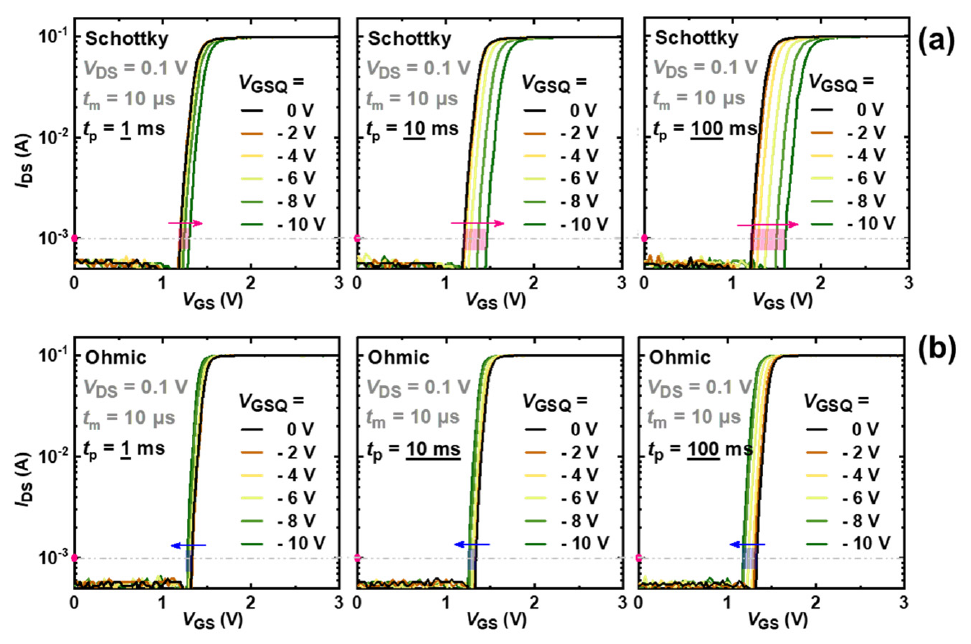
Figure 4. Pulsed transfer characteristic curves with V GSQ , from 0 V to − 10 V, and pulse periods of 1 ms, 10 ms, and 100 ms: ( a ) SG HEMT, ( b ) OG HEMT.